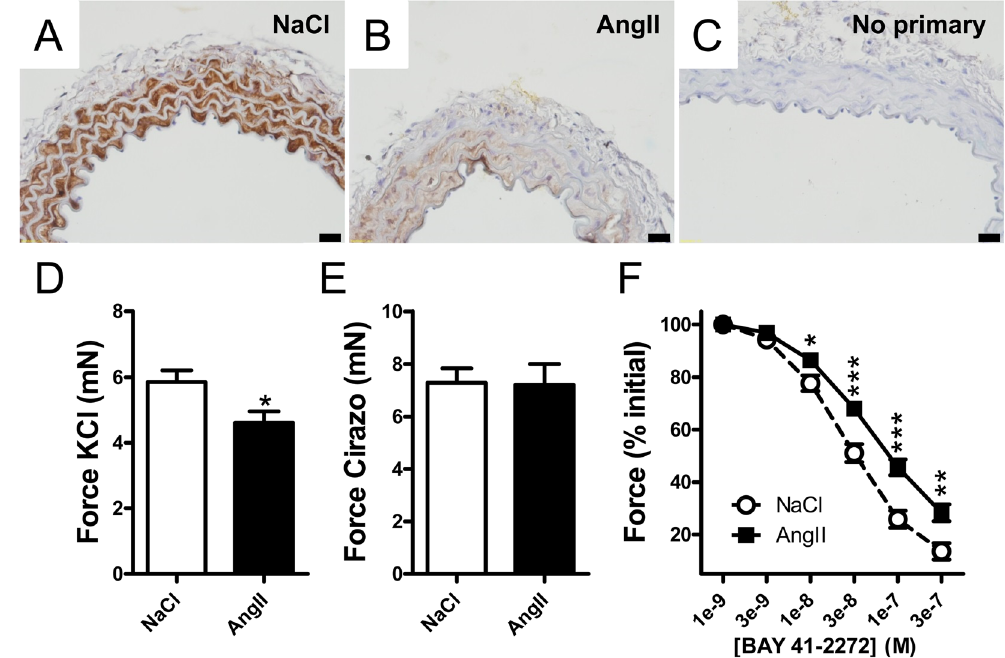
Figure 2. Reduced expression of sGC in the hypertensive aorta. The aorta from vehicle- and AngII-treated mice was isolated and fixed for immunohistochemistry. Panels A and B show staining for GUCY1B3 (brown) as indicated. Panel C represents a primary antibody omission control. Scale bars represent 20 µ m. Aortae were also isolated and mounted for force measurements (n = 8/group) using wire myography. Depolarization-induced (60 mM KCl) contraction was reduced ( D ), but contraction in response to the α 1 -adrenergic agonist cirazoline was unchanged ( E ). In ( F) , preparations were relaxed by sGC activation using BAY 41–2272 following pre- contraction with cirazoline. * P < 0.05, ** P < 0.01, P <